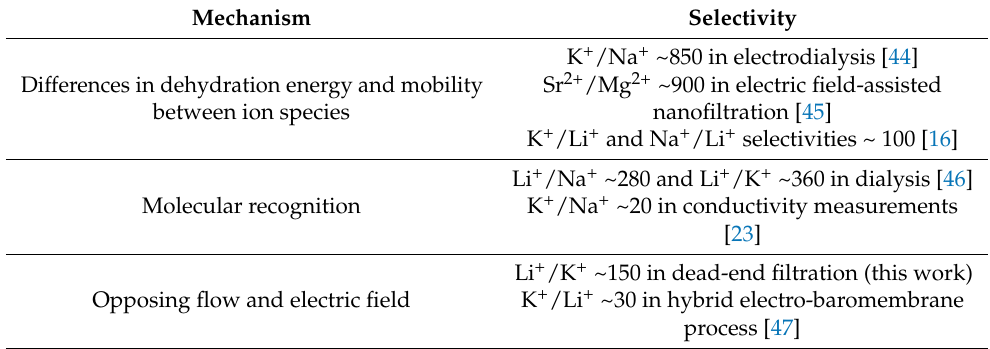
Table 2. Some literature studies that examine membrane-based separations among ions that have the same